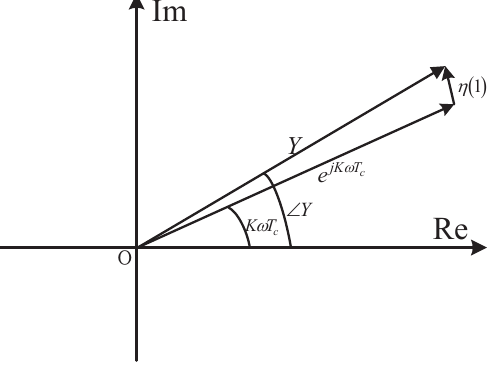
Figure 4. Geomrtirc representation of the measurement Y